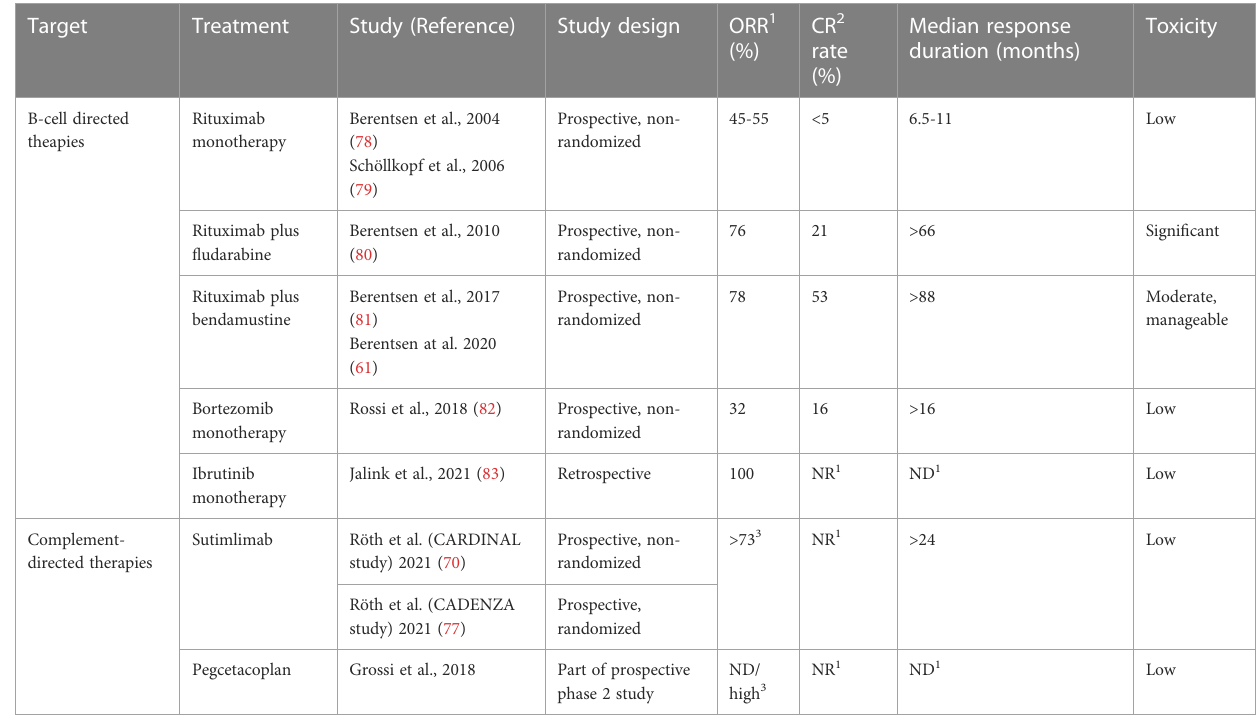
TABLE 3 Published studies of therapy in